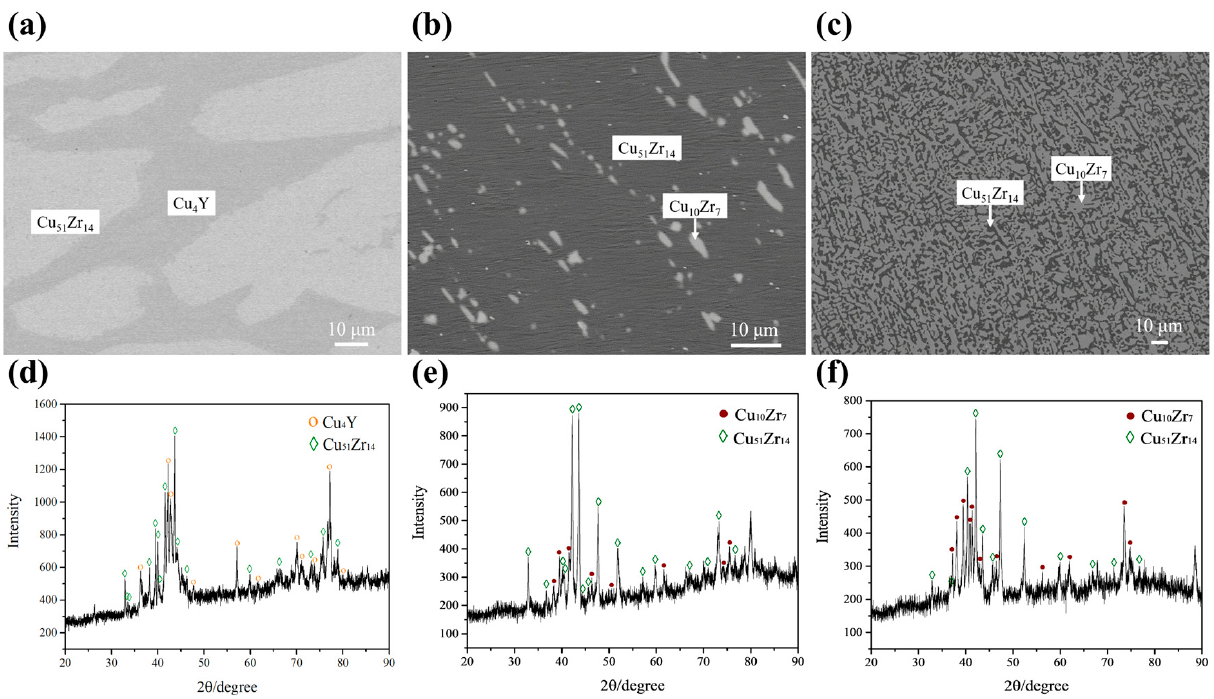
Figure 7. BSE micrographs and XRD patterns of annealed alloys: ( a , d ) A7 Cu 79 Zr 13 Y 8 (at.%); ( b , e ) A11 Cu 78 Zr 18 Y 4 (at.%); ( c , f ) A12 Cu 66 Zr 32 Y 2 (at.%).